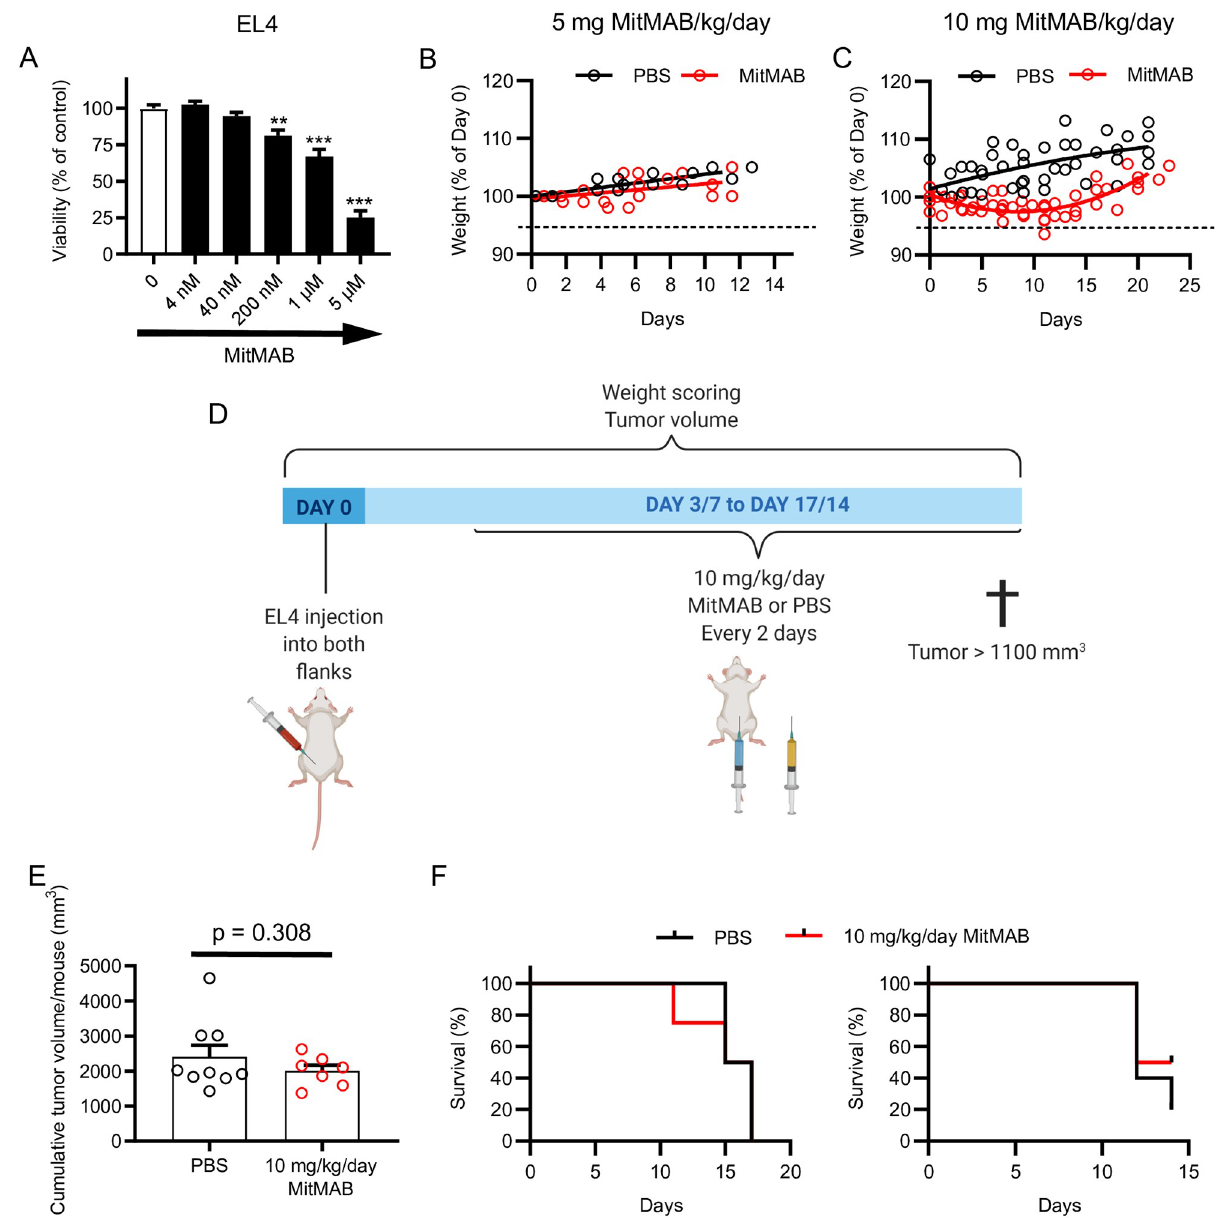
Fig 8. Dynamin inhibition does not prevent EL4 tumor growth in mice. (A) 0.15 x 10 6 EL4 cells were treated with the indicated concentrations of MitMAB for 24 h, followed by cell viability measurement using PrestoBlue (n = 8; data pooled from two independent experiments). Groups were compared to control with one-way ANOVA and Dunnet’s posthoc tests. (B-C) Mice were injected intraperitoneally with 5 (n = 4) or 10 mg/kg/day (n = 4–5) MitMAB in PBS or PBS alone. Weight is shown relative to the treatment start and the dashed line indicates the ethical end point (5% weight loss). In (B), linear regression was used (p = 0.387); in (C) nonlinear fits are shown (two way ANOVA for treatment factor p < 0.0001%). (D-F) Mice were injected subcutaneosly with 5 x 10 5 EL4 cells. After 3 or 7 days, treatment with MitMAB (10 mg/kg/day) was initiated (weight loss of 10% as ethical endpoint in this experiment). (E) Pooled tumor volume endpoints from two independent experiments. Every point shows the total tumor burden in a mouse (from both flanks). The groups were compared with Welch’s two-tailed t-test, n = 7–9. (F) Survival curves for the two experiments, with MitMAB treatment initiated on either day 3 (left graph), or day 7 (right graph).